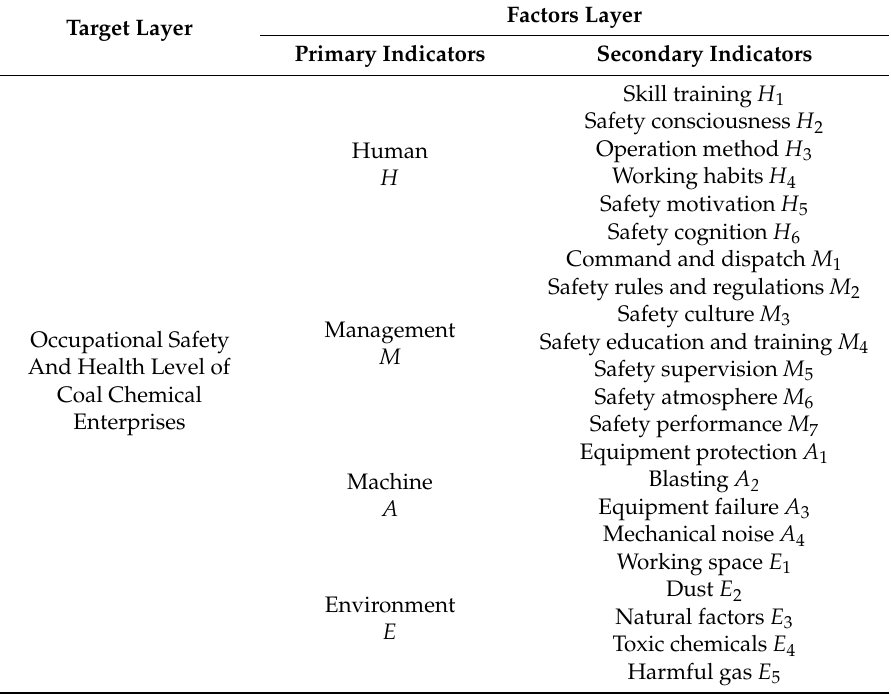
Table 1. Occupational safety and health (OSH) influencing factors indicator